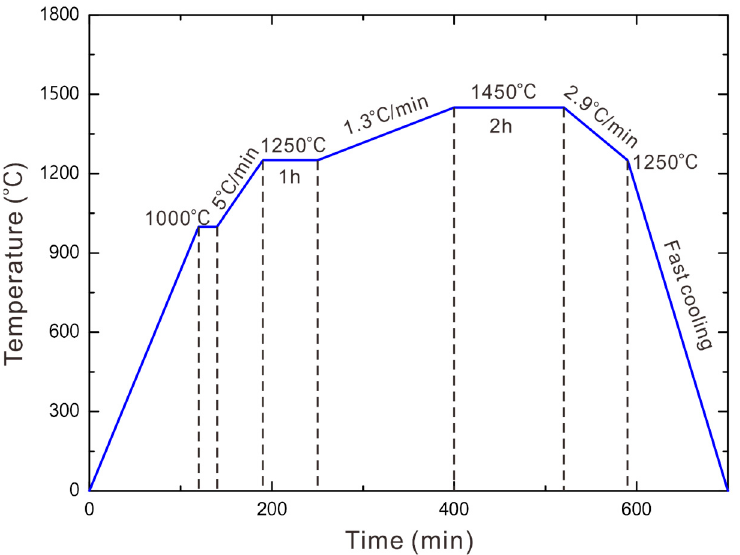
Figure 3. The strategy of the sintering process of WC-Co-Ni designed through thermodynamic